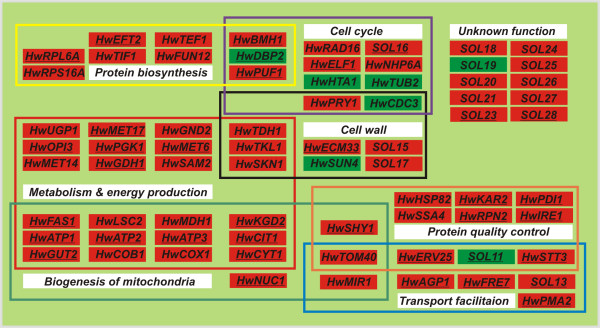
Model of gene interactions through functional modules responsible for the adaptive metabolism of H. werneckii in an extremely hypersaline environment. Interactions between functional modules are presented by overlapping frames. For visualization purposes, up-regulated genes are presented in red boxes and down-regulated genes are in green boxes. HwHog1-ChIP positive genes are underlined.